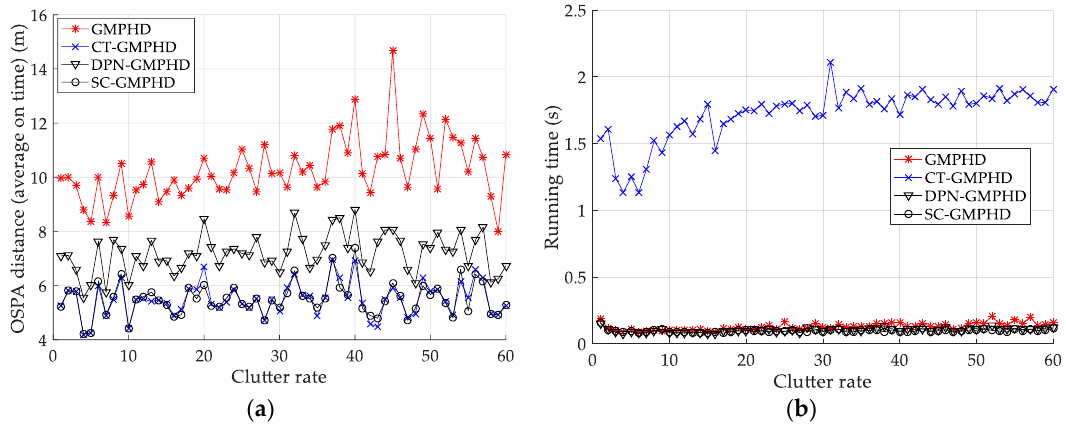
Figure 9. Filtering performance comparison of four filters for a target on a curved road: ( a ) standard